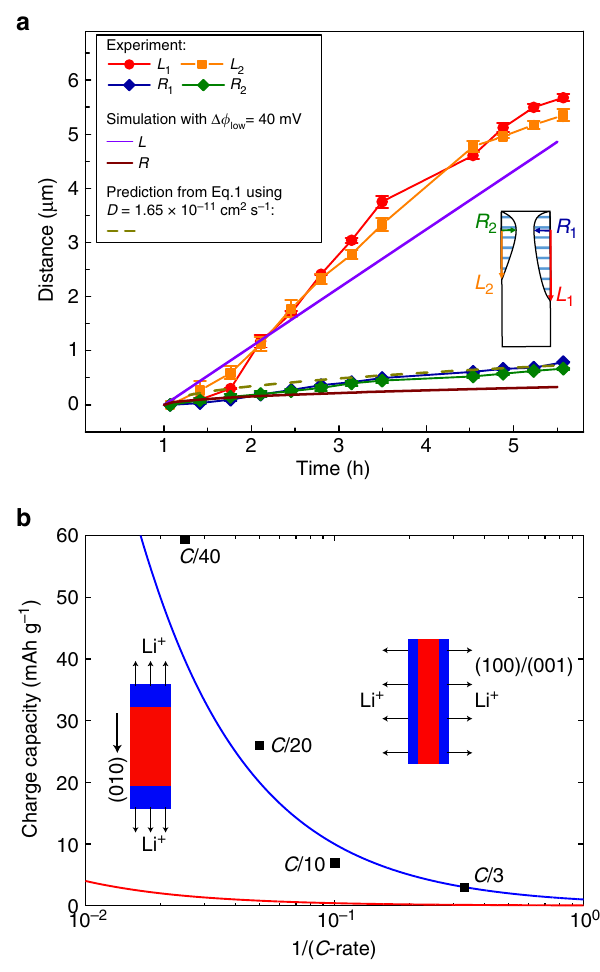
Fig. 4 Experiment-modeling comparison of phase growth and charging kinetics. a Time evolution of [100]/[001] ( R 1 and R 2 ) and [010] ( L 1 and L 2 ) dimensions of the two FePO 4 domains in the LiFePO 4 particle during delithiation, compared against prediction from Eq. 1 with D = 1.65 × 10 − 11 cm 2 s − 1 (dashed line) and phase- fi eld simulation (solid lines) with ϕ low = 40 mV (see text). The inset schematically shows how R and L are measured. The measurements are performed on phase maps 4 – 17 (starting at t = 1.070h). R and L represent the width and length of the FePO 4 region at its widest point (from the two nucleation sites near the two top corners of the microrod). b Galvanostatic charging capacity of LiFePO 4 electrode at different C -rates vs. predictions from a simple delithiation model assuming D = 10 − 11 cm 2 s − 1 and that the delithiation front propagates along [100]/ [001] (blue line) or [010] (red